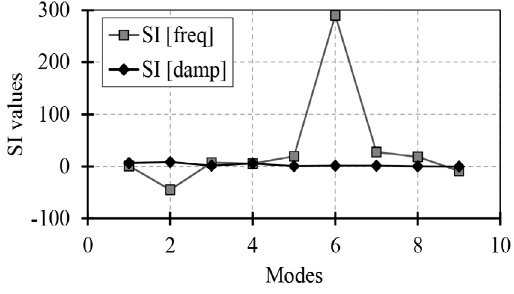
Figure 11. Damage detection by the Unified Significance